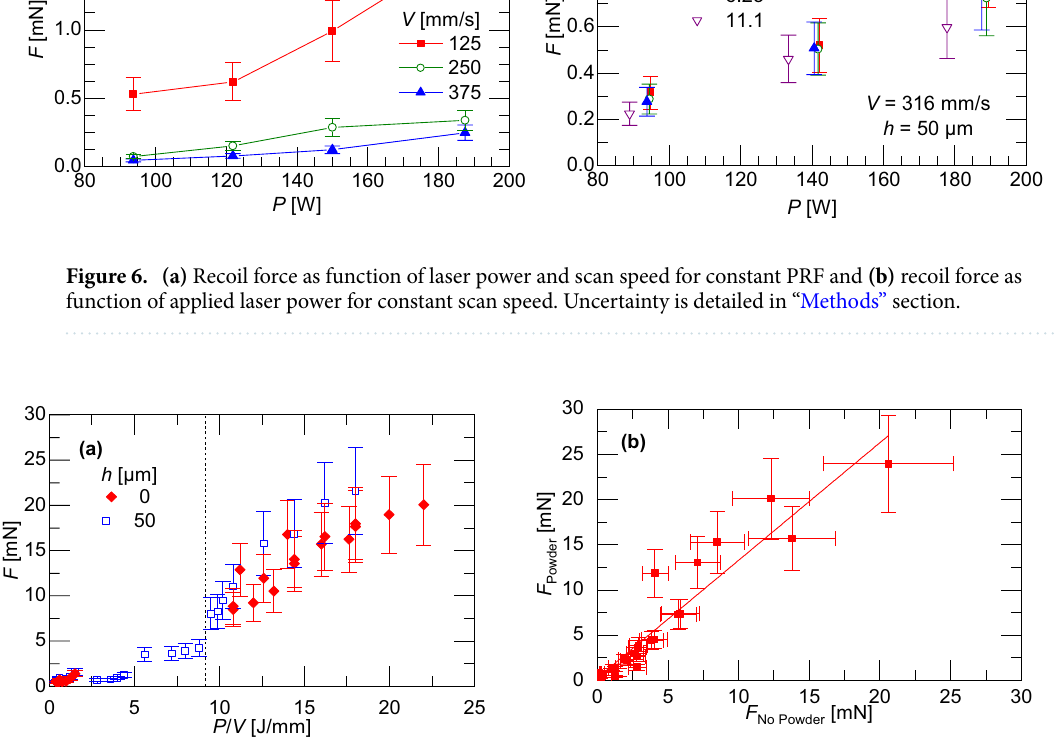
Figure 7. (a) Recoil force as function of linear energy density for both powder and no powder being and (b) recoil force magnitude comparison for both powder and no